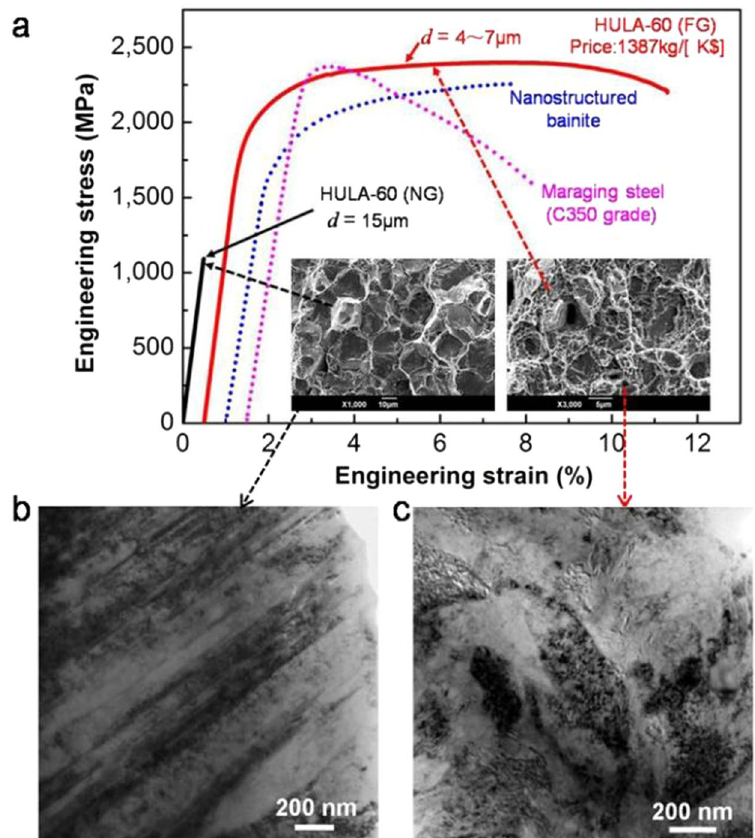
Figure 1. Comparison of mechanical properties of HULA-60 with other alloys as well as the grain size effect on the martensite substructures of HULA-60. ( a ) Engineering stress-strain curves of the NG (15 μ m) and FG (4~7 μ m) HULA-60 (see Supplementary Table S4 for details) samples as compared with a C350 grade maraging 60. ( c ) Dislocation-substructured martensite in FG